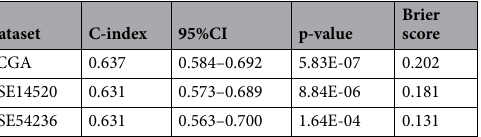
Table 1. Performance of the model using mean expression distance as the risk score in the TCGA cohort and GEO datasets.